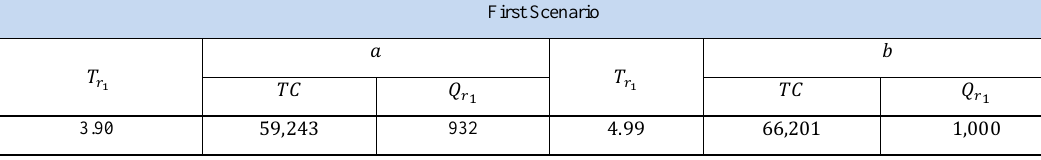
Table 3. Scenarios and optimal solution for one item (Item